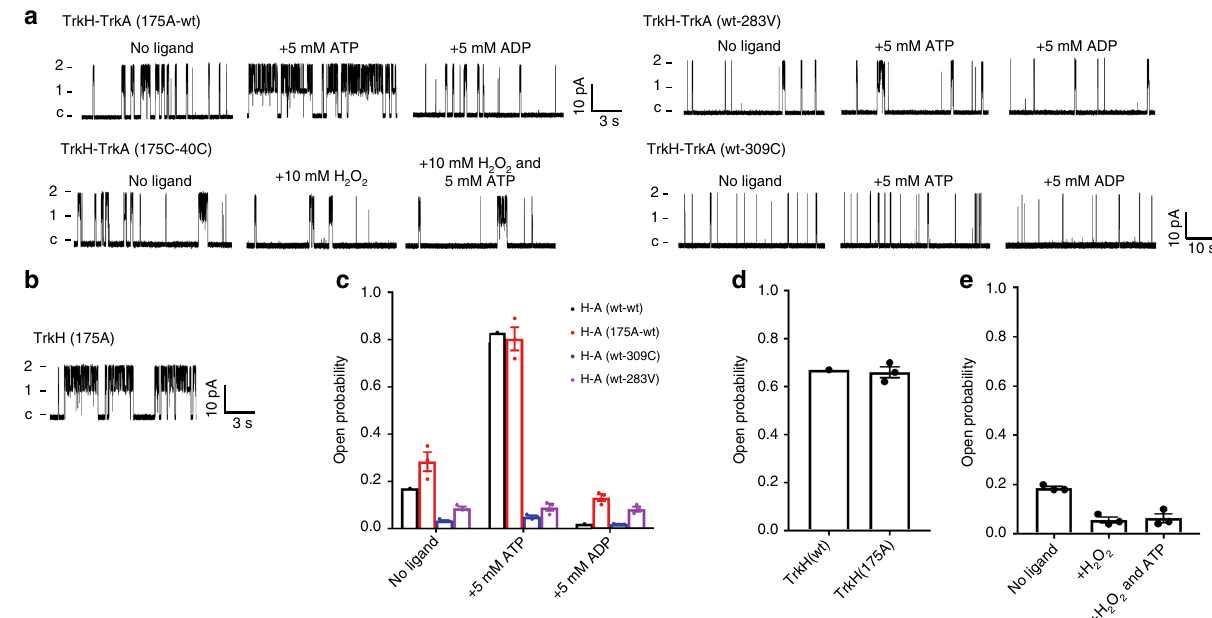
Fig. 6 Single-channel activities of TrkHA mutants. a Current traces of different TrkHA mutants. Top left: Current traces of TrkHA (175A-wt) in the presence of no ligand, 5 mM ATP, or 5 mM ADP. Bottom left: Current traces of TrkHAc (175C-40C), in the presence of no ligand, 10 mM H 2 O 2 , and both 10 mM H 2 O 2 and 5 mM ATP. Top right: Current traces of TrkHA (wt-283V) in the presence of no ligand, 5 mM ATP, or 5 mM ADP. Bottom left: Current traces of TrkHA (wt-309C) in the presence of no ligand, 5 mM ATP, or 5 mM ADP. The scale bar for TrkHA (wt-309C) is 10 pA/10 s, while the scale bar for all other TrkHA mutants are 10 pA/3 s. b Current traces of TrkH 175A (scale bar: 10 pA/3 s). c Open probabilities of TrkHA (wt-wt, 175A-wt, wt-309C, and wt-283V) in the presence of no ligand, 5 mM ATP, or 5 mM ADP plotted in dots overlap with bar graph. Error bars in c – e are standard error of the mean (s.e.m.). Charts in c – e were prepared in GraphPad Prism. d Open probabilities of TrkH (wt) and TrkH (175A) plotted in dots overlap with bar graph. e Open probabilities of TrkHA (175C-40C) in the presence of no ligand, 10 mM H 2 O 2 , or both 10 mM H 2 O 2 and 5 mM ATP plotted in dots overlap with bar